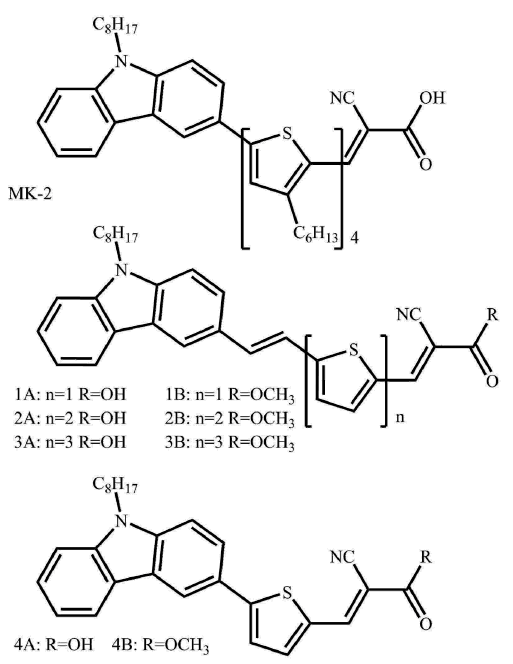
Figure 1 . Structure of MK-2, [22] dye ( top ) and the series of D-A dyes studied ( below ).